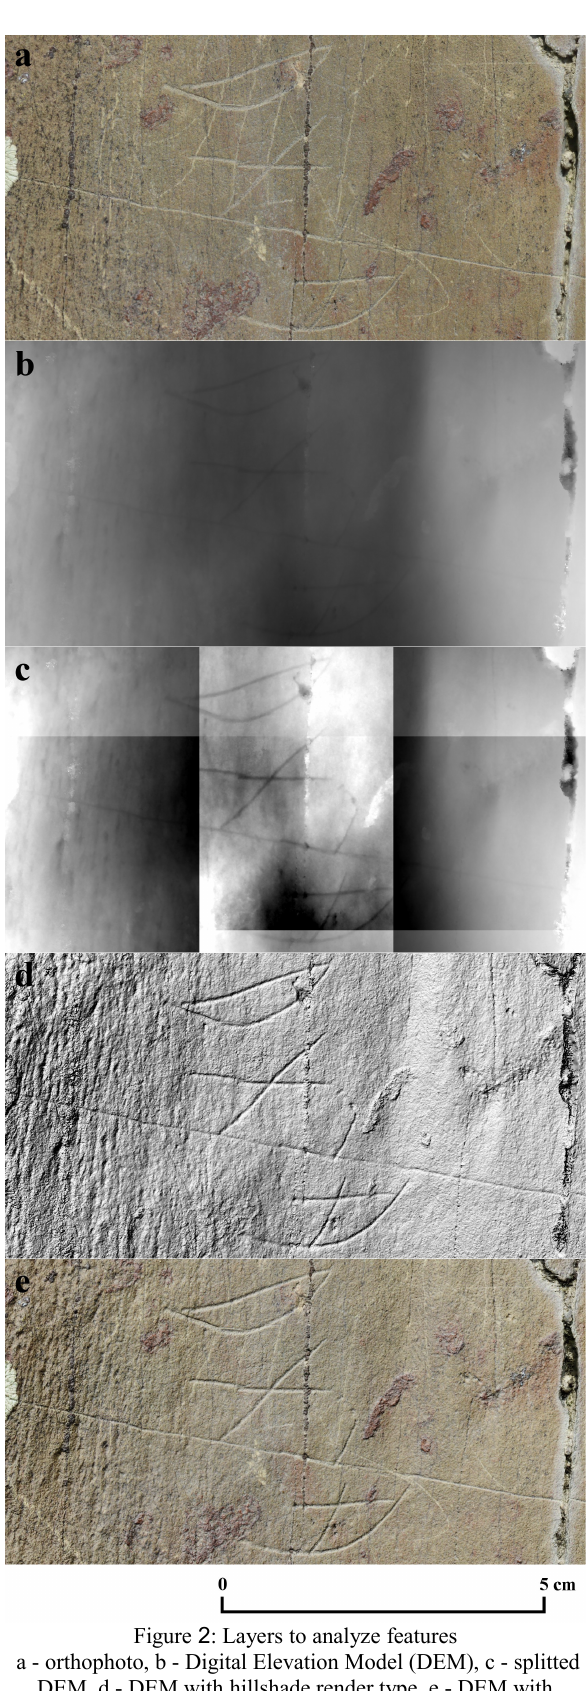
Figure 2 : Layers to analyze features a - orthophoto, b - Digital Elevation Model (DEM), c - splitted DEM, d - DEM with hillshade render type, e - DEM with hillshade render type in the soft light blending mode over the